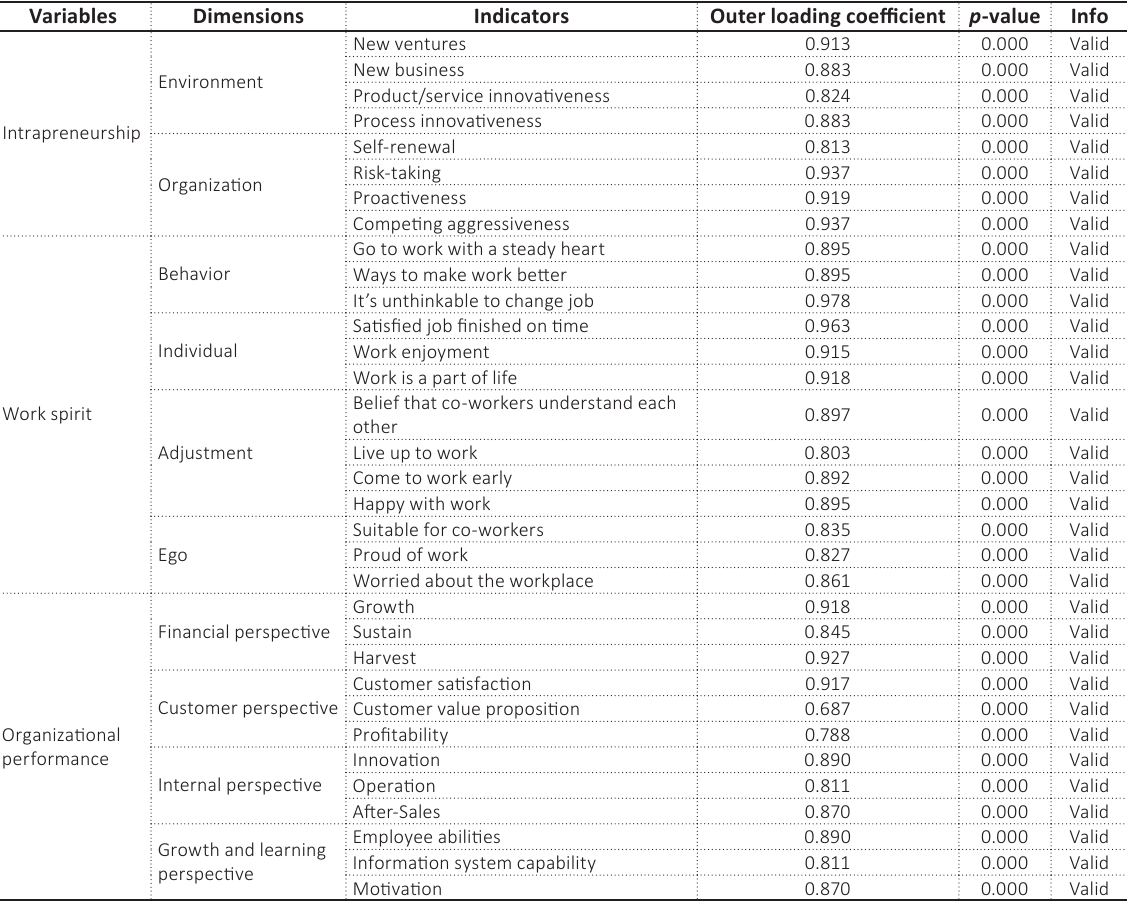
Table 2. Validity and reliability